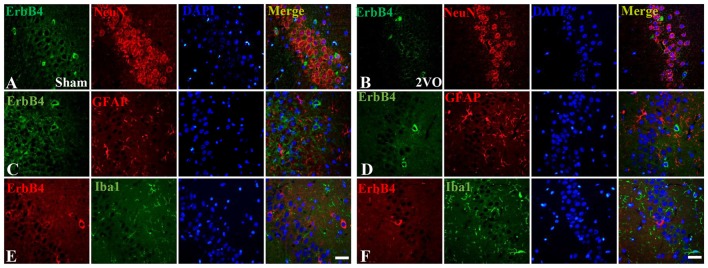
The co-localization of ErbB4 with neurons, microglia and astrocytes at 28 days. The representative images in the sham group are listed in the left four columns (A,C,E) and the images in the 2VO group are listed in the right (B,D,F). Horizontal bar = 50 μm. Note that ErbB4 is mainly expressed in NeuN-positive cells.